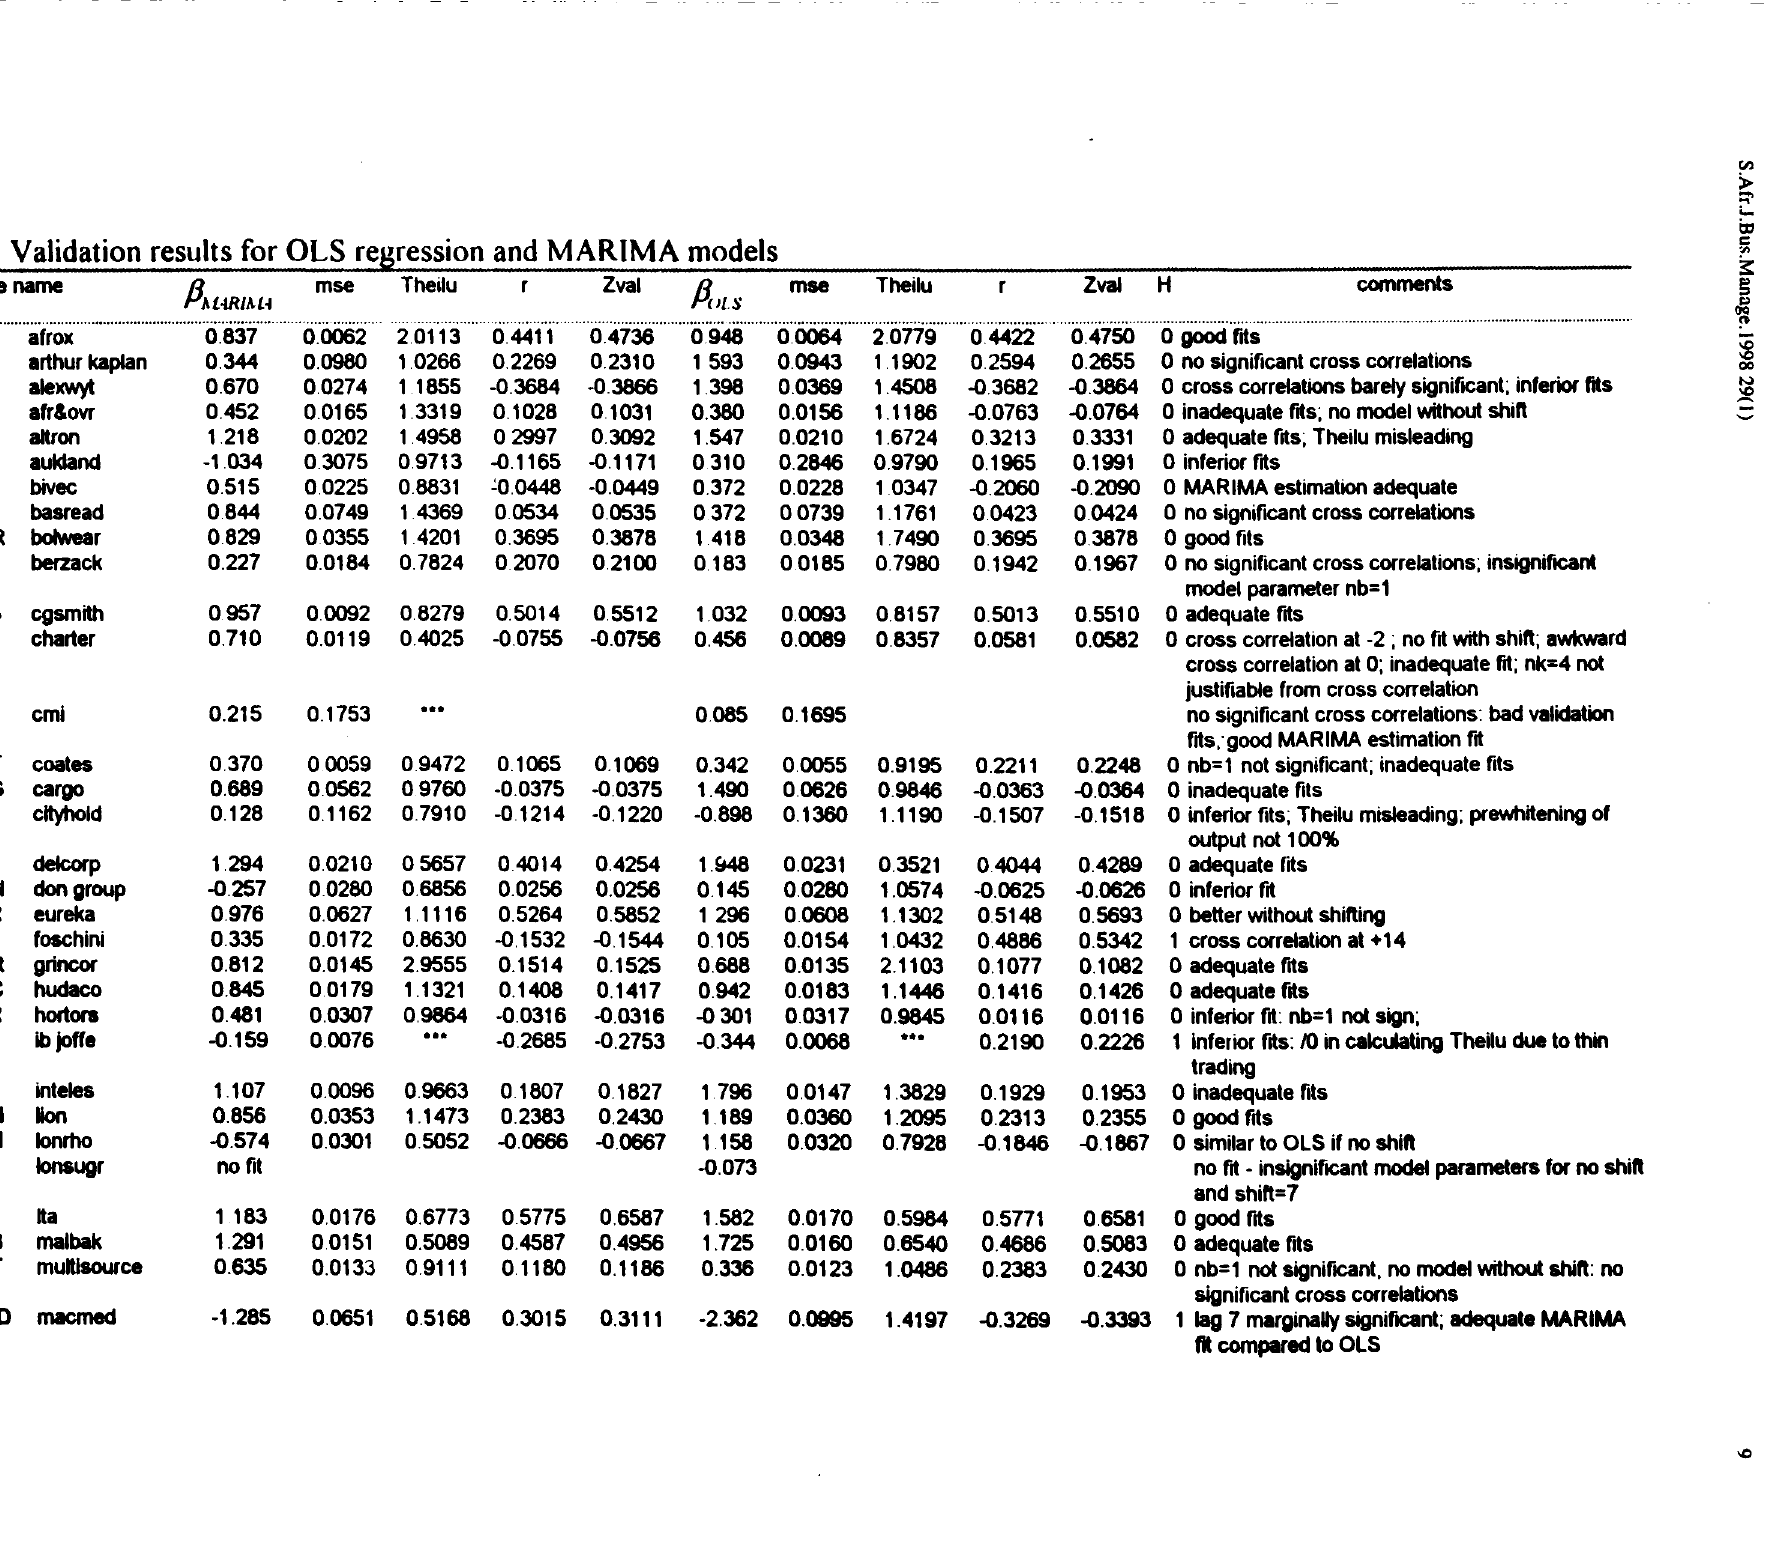
Table 3 Validation results for OLS re~ression and MARIMA